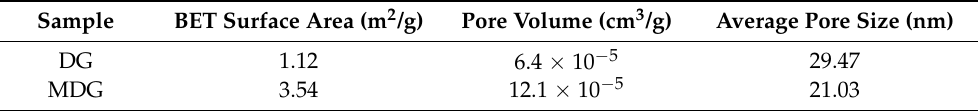
The effect of pH of aqueous solution on adsorption of MG onto MDG is shown in Figure 9a. The adsorption capacity and adsorption removal rate increased as the pH rose from 1.0 to 6.0, and remained stable as the pH rose from 6.0 to 11.0. This is because MG is a cationic dye and, under acidic conditions, MG and H + have the same charge, both